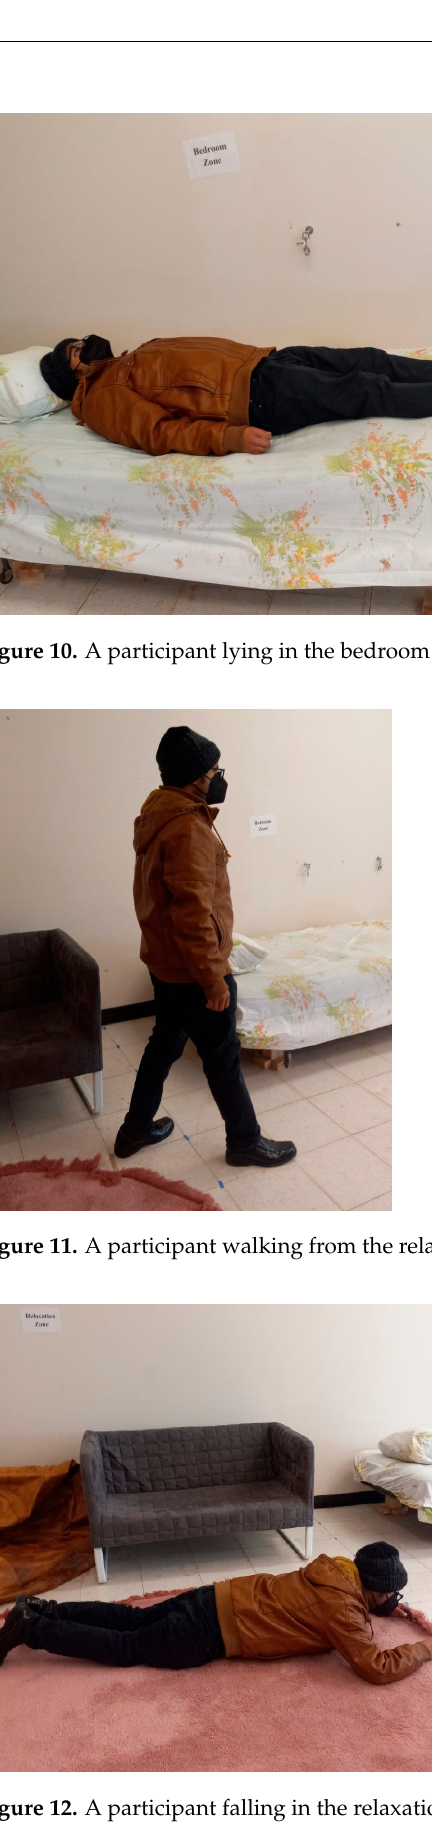
Figure 13. A participant falling in the relaxation zone. Here, a sideways fall is demonstrated. The original plan was to test all the proposed functionalities of this system by includ- ing 20 volunteers (ten males and ten females) for user diversity [97]. However, no one predicted the widespread COVID-19 pandemic [98], the declaration of a national emer- gency in the United States on account of the same [99], and the subsequent lockdown for several months with more than 517,572,198 cases of COVID-19 with 6,277,510 deaths on a global scale [100]. In the United States alone, at the time of writing this paper, there have been 83,644,452 cases of COVID-19 with 1,024,655 deaths [100]. Therefore, it was not pos- sible to recruit 20 volunteers. As a result, we were able to perform the proposed experi- ments with only one volunteer. This is one of the limitations of this study, which we plan to address in the near future by recruiting more volunteers for the experiments. While this is a limitation of this study, upon reviewing prior works in this field, we observed that there have been several real-world systems for fall detection, indoor localization, and as- sisted living, the effectiveness of which was evaluated by one volunteer or participant. Some examples include the works of Godfrey et al. [47], Liu et al. [48], Dinh et al. [49,50], Townsend et al. [51], Dombroski et al. [33], and Ichikari et al. [34] (VDR Track), just to name a few. This is further illustrated in Table 2.